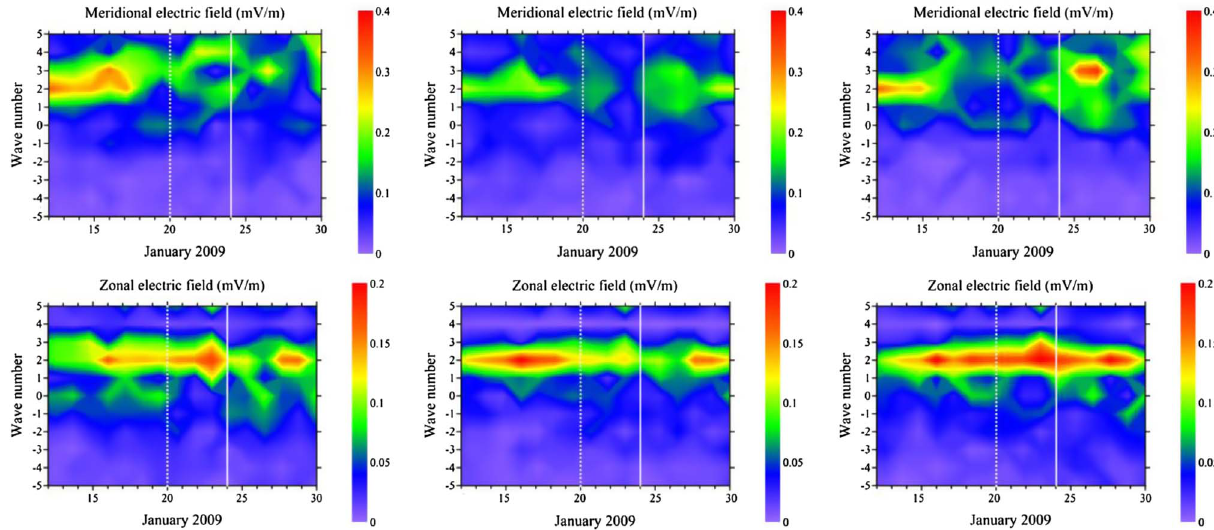
Fig. 7. Spectra of the EAGLE-simulated semidiurnal tidal variations in the meridional (top) and zonal (bottom) components of electric fi eld at 20 (cid:3) N (left), equator (middle), and 20 (cid:3) S (right) at 175 km altitude. Vertical lines indicate the onset (dotted) and peak (solid) of the 2009